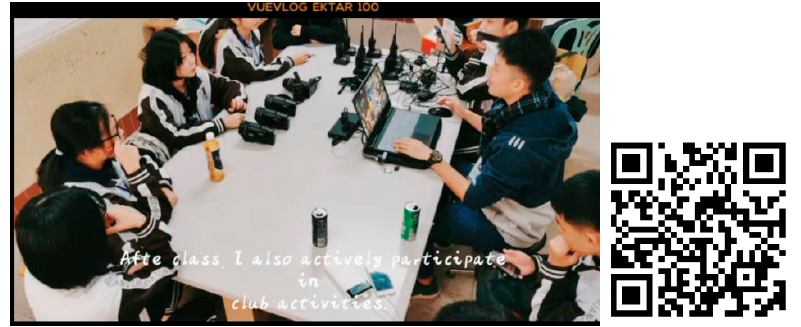
Figure 2. Learner’s vlog.